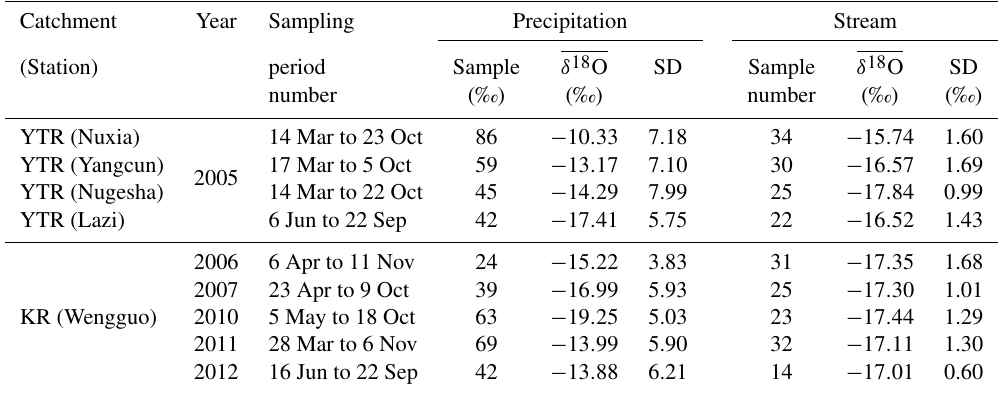
Table 1. Summary of precipitation and stream water samples in the YTR and KR catchments. Catchment Year Sampling